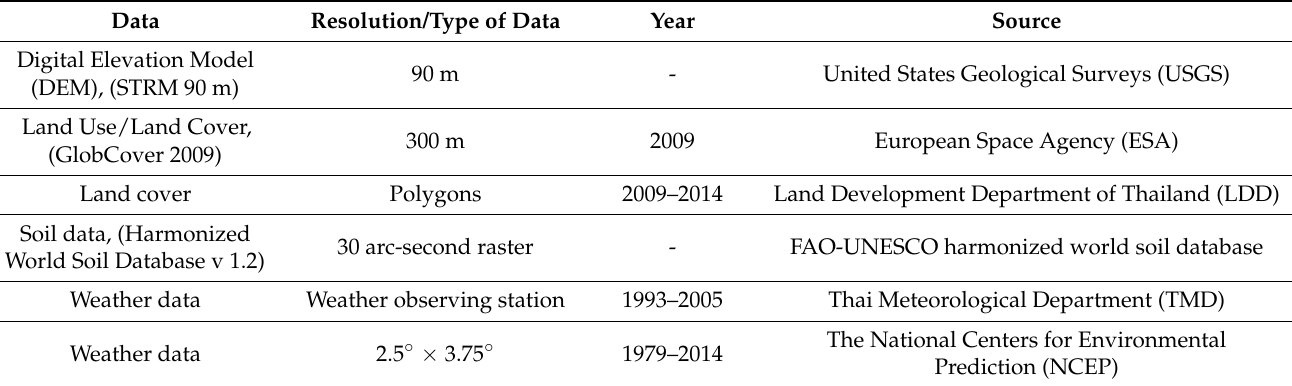
Table 2. List of data used in this work for SWAT2012